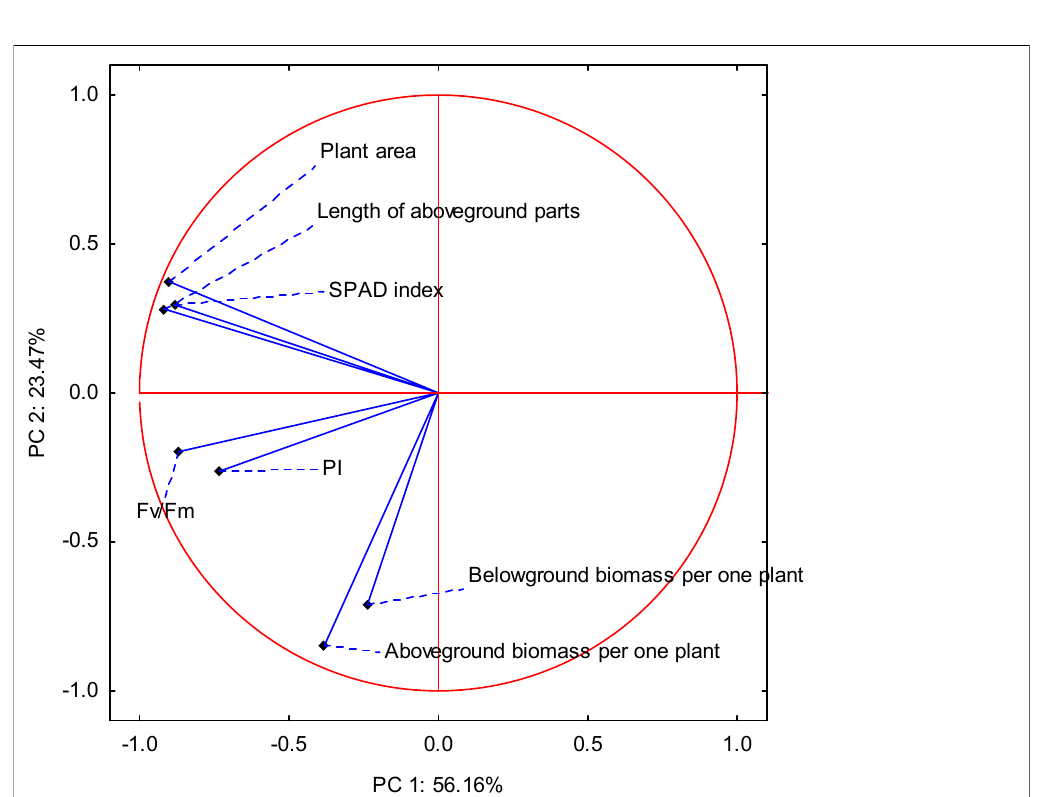
Figure 6. PCA analysis chart for the growth and physiology of herbicide-susceptible and -resistant biotypes of wild oat.